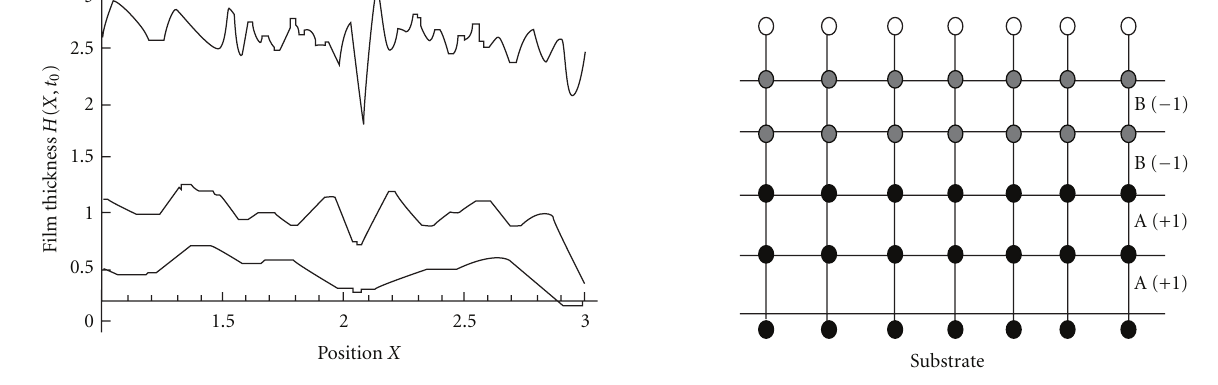
Figure 5: The figure shows amplitude modulations in spinodal decomposition perturbations with higher harmonics show typical variation in it.